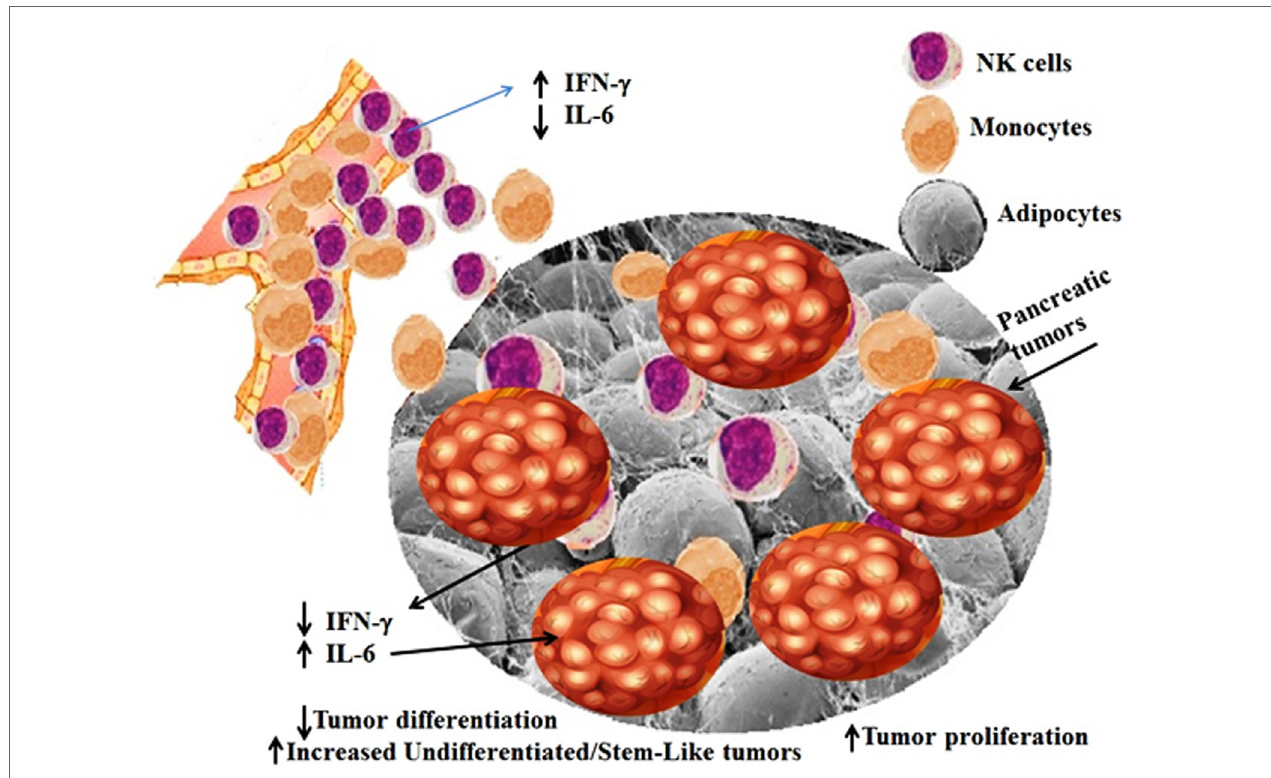
FigUre 4 | Schematic representation of hypothetical model of interaction between NK cells, adipose tissue, and pancreatic tumors. Adipose tissue within and around tumor microenvironment can contribute to the increased proliferation of pancreatic tumors through the increase in induction of IL-6 in the presence of decreased IFN- γ secretion by the NK cells. NK cells and monocytes are recruited to the peri-pancreatic and pancreatic adipose tissue from the circulation, where they are conditioned by the adipose tissue to lose secretion of IFN- γ , while increasing synergistically secretion of IL-6 by the peri-pancreatic and pancreatic adipose-derived cells. Since pancreatic tumors have a predilection to grow in the adipose tissue, these tissues are likely to convert tumor suppressive NK cells, to tumor-promoting cells, by decreasing NK-mediated cytotoxicity and IFN- γ secretion and allowing an increased secretion of IL-6 within the tumor microenvironment. Increased IL-6 secretion is instrumental in aiding in tumor growth and